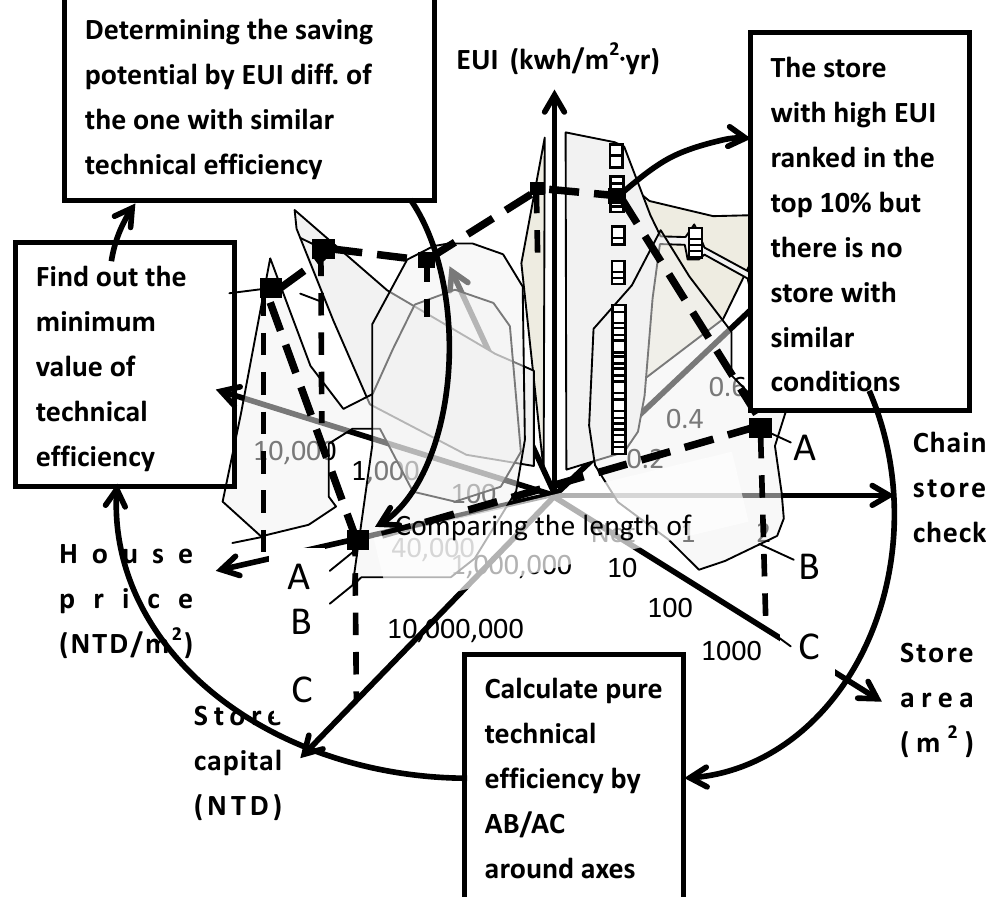
Figure 7. Pure technical efficiency analysis as the third algorithm data array analyzer: some stores with high energy usage may have no store with similar conditions. Pure technical efficiency is used to determine energy-saving potential from the data array by comparing EUI difference of the one with the most similar